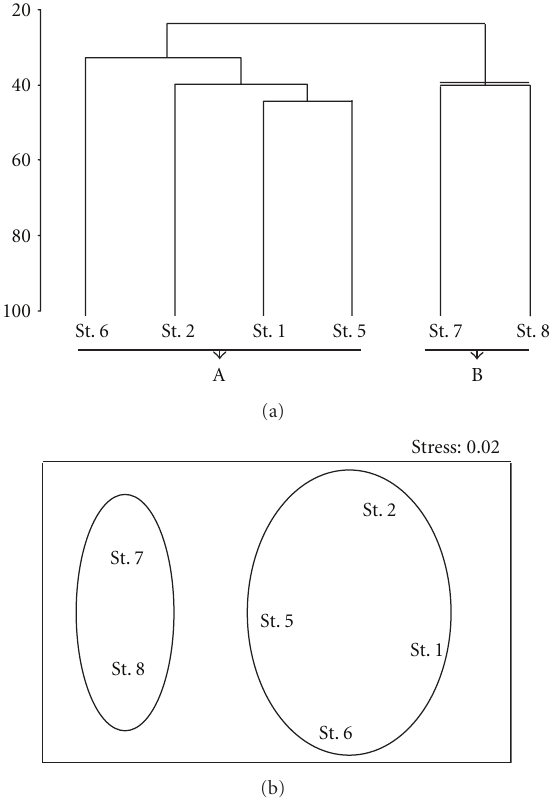
Figure 3: Classification and ordination analysis of studied stations made from absence-presence data of species matrix for the studied stations in Bahia Malaga estuary: (a) Bray-Curtis similarity dendro- gram and (b) nMDS ordination (stress value < 0.02).